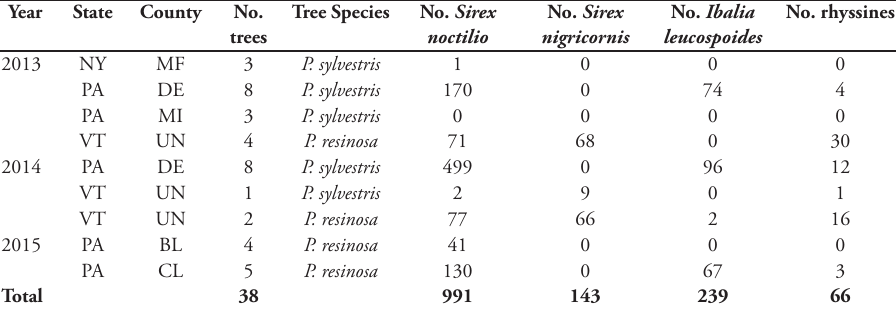
Table 2. Summary of trees and emerging insects sampled in each year of study. Number of trees sampled and number of native Sirex nigricornis , non-native S. noctilio and Sirex spp. parasitoids ( Ibalia leucospoides and the rhyssines) collected from each tree species, at each site, across sampling